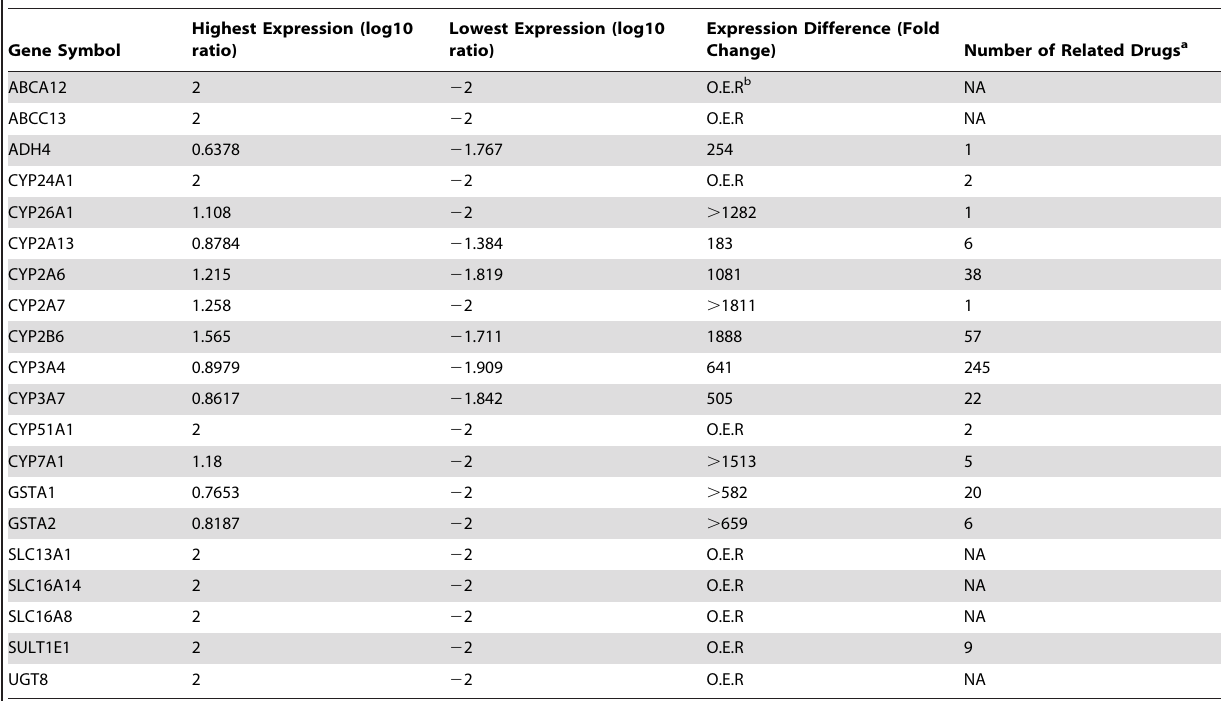
Table 1. Interindividual Variability of the 20 Most Variably Expressed DMET Genes among 427 Subjects.